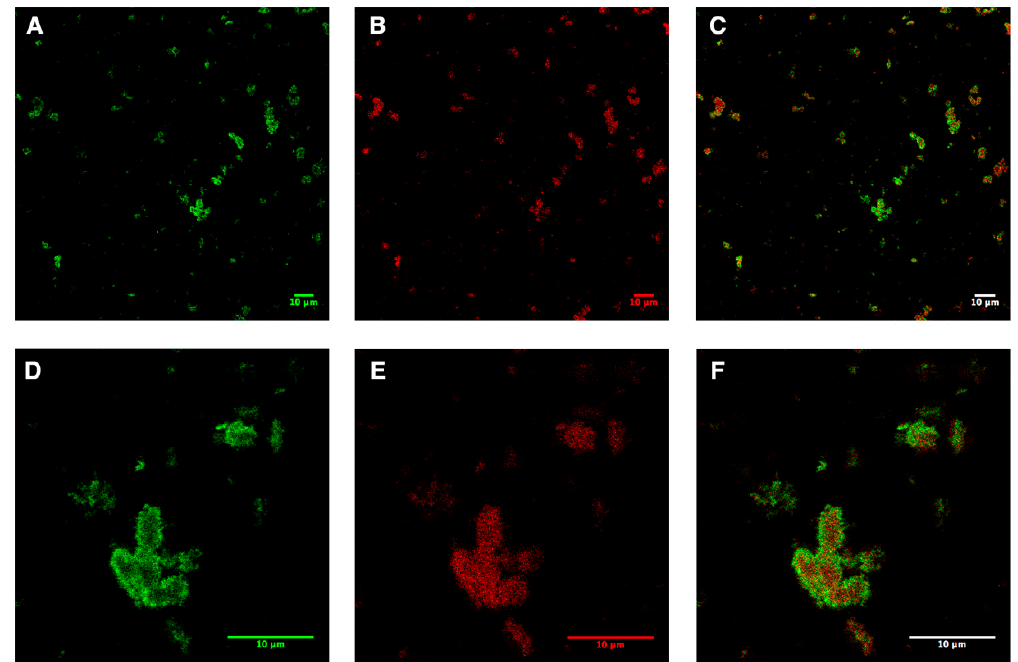
Figure 2. Confocal microscopy analysis of AqpZ-sGFP pellet fractions produced from L -CFPS directly after expression. A and D , signals of sGFP in the pellet fractions shown in green; B and E , signals of lipids in the pellet fractions in red (stained via Nile red); C and F , merged images of the green and red channels. Scale bar indicates 10 μ m.